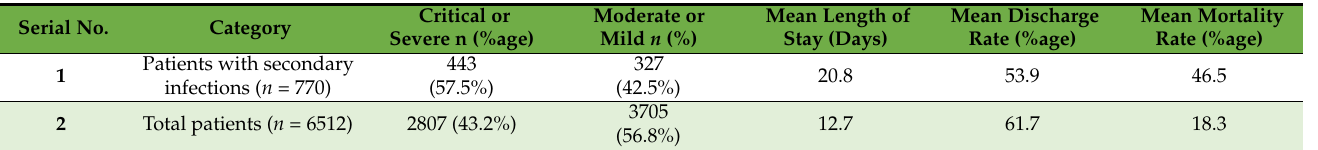
Table 1. The comparison of disease severity, mean length of stay in hospital, mean discharge rate, and mean mortality rate among patients with secondary infections and normal COVID-19 patients.